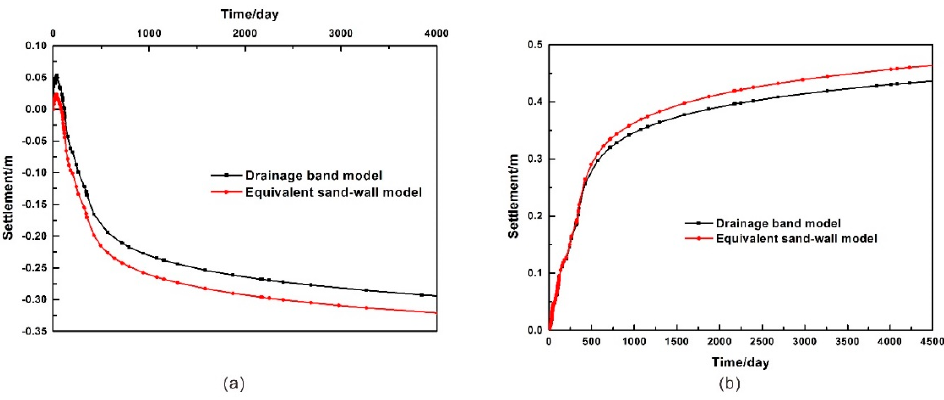
Figure 13. Horizontal displacement of the lateral toe of the slope: ( a ) A point; ( b ) G